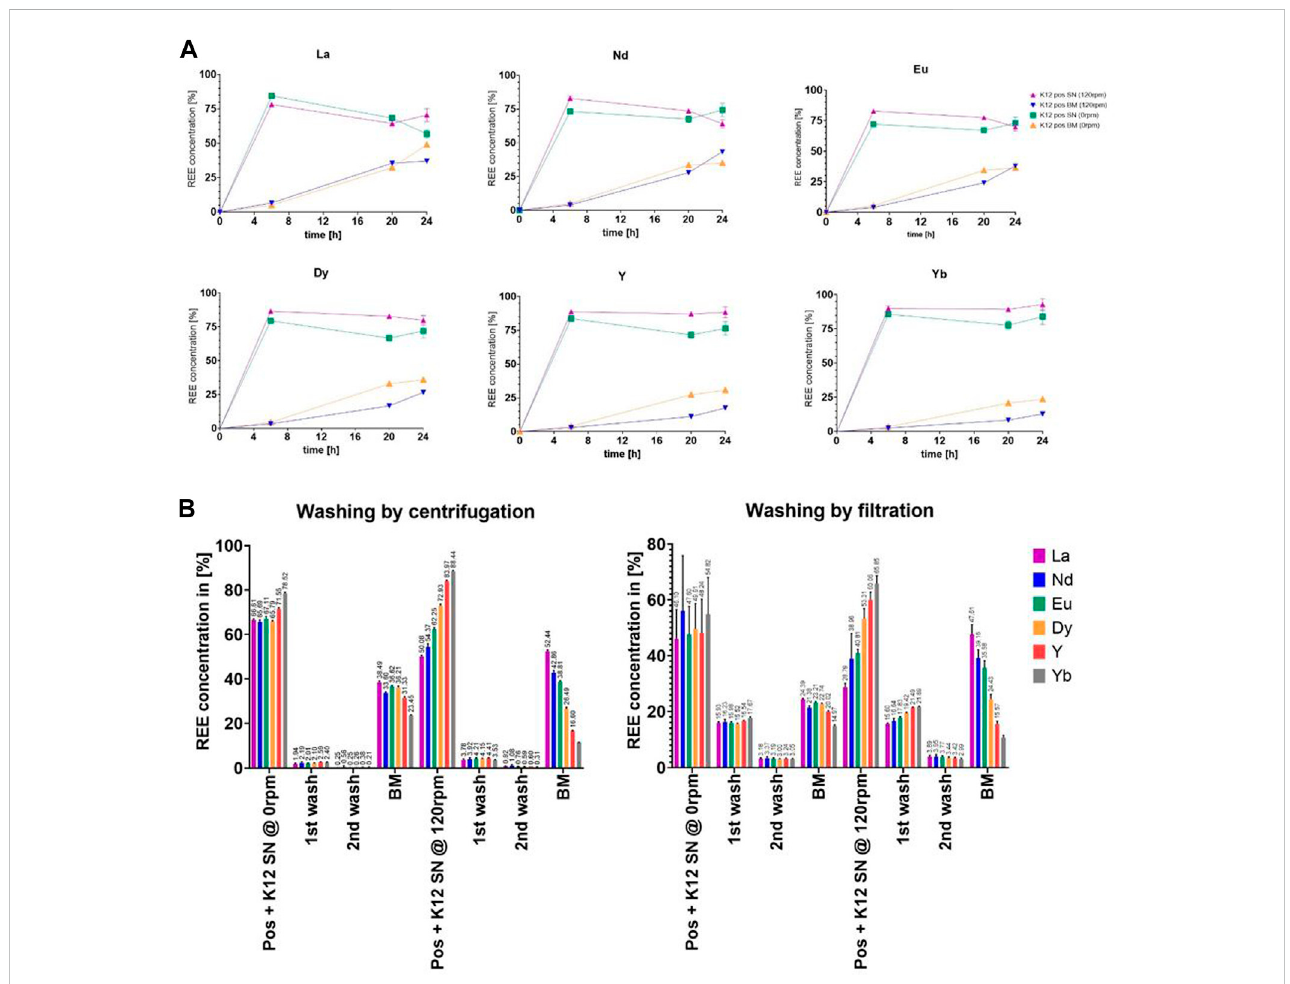
FIGURE 7 (A) Comparisonoftheuptakeofsixchosenelementsastherepresentationofthefullsetoflanthanides( Y -axis:percentageofthetotalconcentration[%]; X -axis:time[h]). (B) Analysismeasurementsoftheuptakeofsixchosenelementsaftereachwashingstepinthepercentageoftotalretrieval.Allmeasurements are given as percentages of the calculated fi nal concentration of 2.25